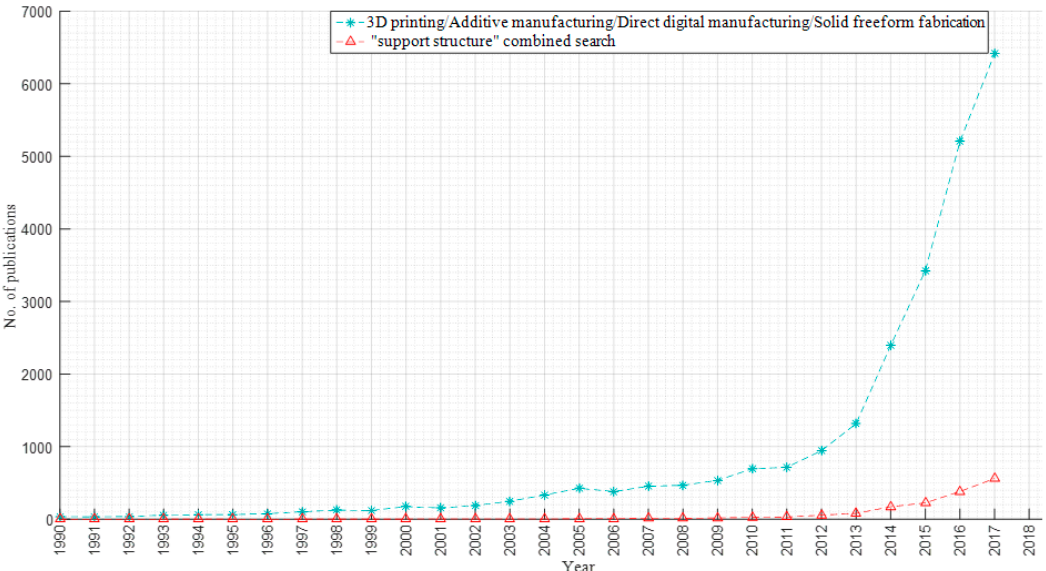
Figure 2. Number of published papers with keywords “3D printing”/“additive manufacturing”/“direct digital manufacturing”/“solid freeform fabrication” and these keywords combined with “support structure”. (Scopus: 29 January 2018).